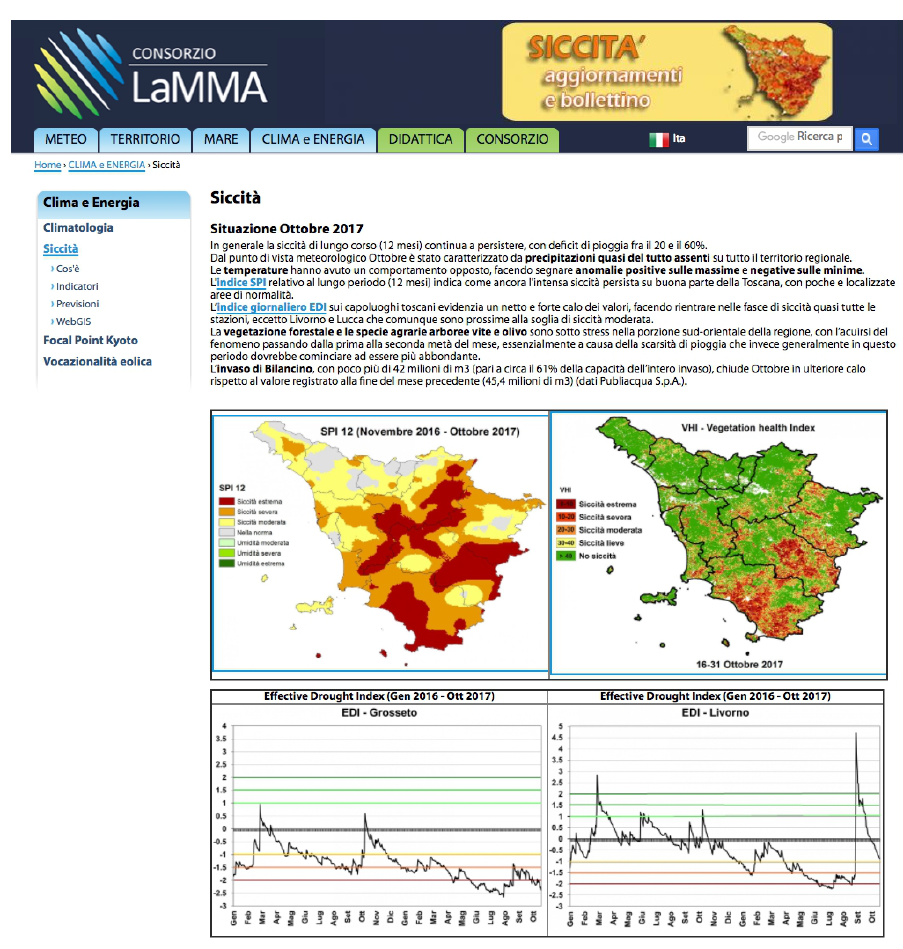
Figure 11. Web page with a recap of the situation of the current